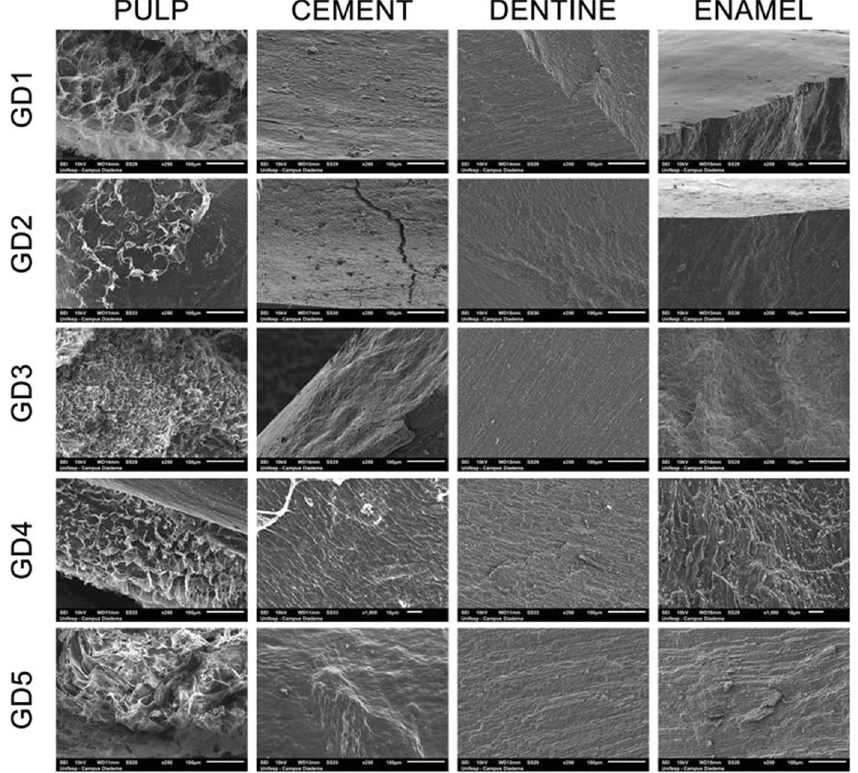
Figure 1. SEM images, obtained at EVO MA ZEISS equipment from UNIFESP, did not evidence visual changes on dentine structure, but presented an apparent smoothing on enamel surface (GD1, GD2, GD3 and GD5), and also some cracks on the cement at GD2 and GD3 (the possibility of being caused by cutting process is not discarded).